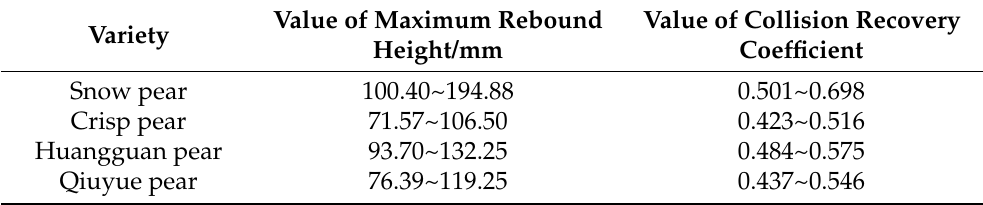
Table 10. Measured values of collision recovery coefficients between typical